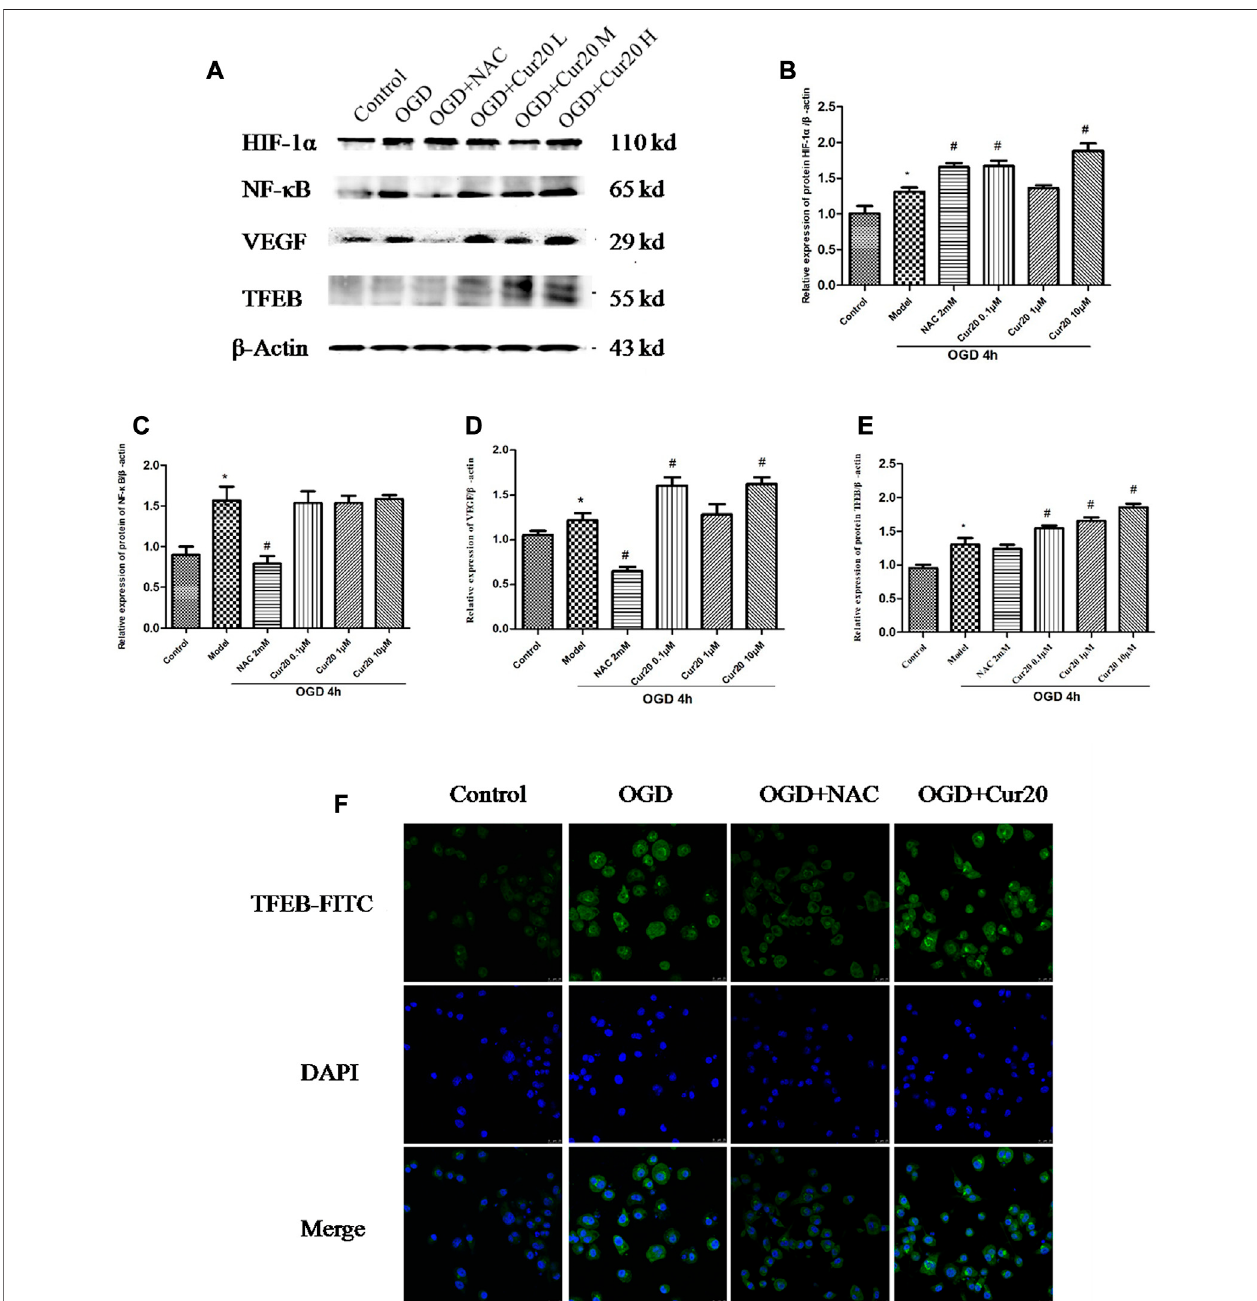
FIGURE 9 | Effect of Cur20 on the HIF-1 α /VEGF/TFEB pathway. A – E , The protein levels of HIF-1 α , NF- κ B, VEGF, and TFEB analyzed by western blot. F , The content and translocation of TFEB in nuclei observed by confocal microscopy with immuno fl uorescence. rBMECs were pretreated with Cur20 for 2 h then treated with OGD for 4 h. L, M, or H represents the concentration of Cur20 as 0.1, 1, 10 μ M, respectively. In the immuno fl uorescence experiment, the concentration of Cur20 was 10 μ M. The experimental data was expressed by mean ± SD, n (cid:2) 3.* p < 0.05 vs. control group, # p < 0.05 vs. Model group.